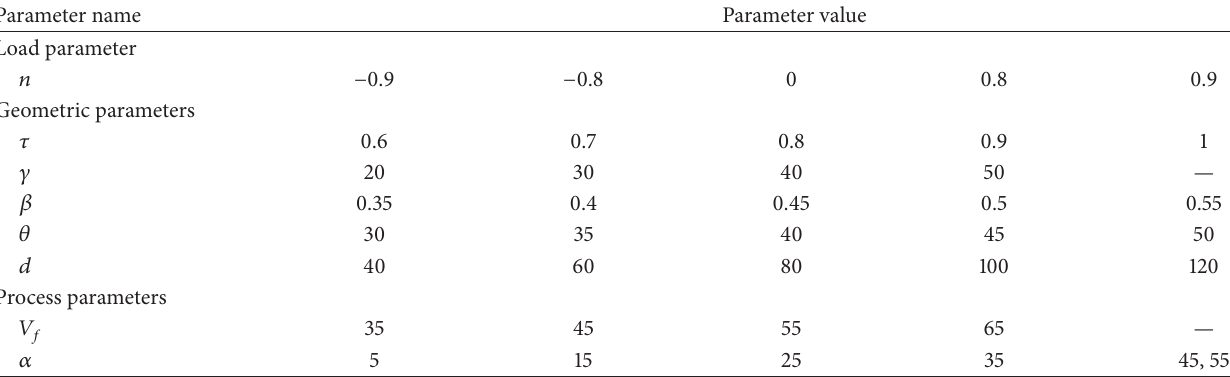
Table 4: Joint parameters and the parameters values.